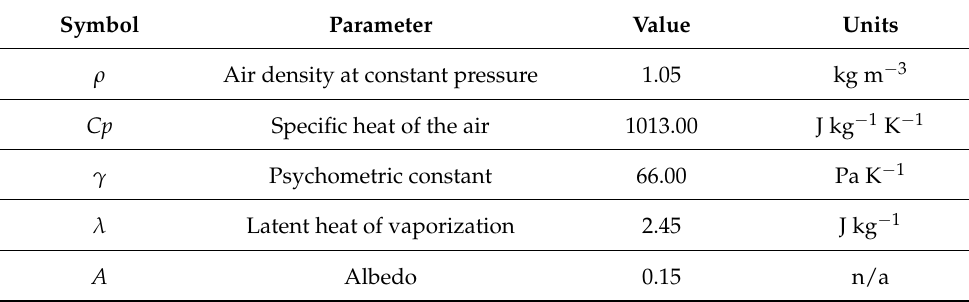
Table 4. Parameters and constants used in the calculation of evaporation E o .